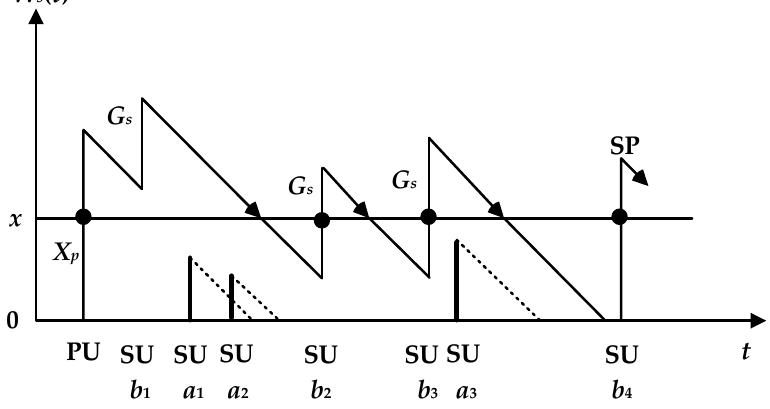
virtual waiting time of a would-be time- t arrival with the probability density function f sw ( x ) . The sample path of W s ( t ) ( t ≥ 0 ) is shown in Figure 1.